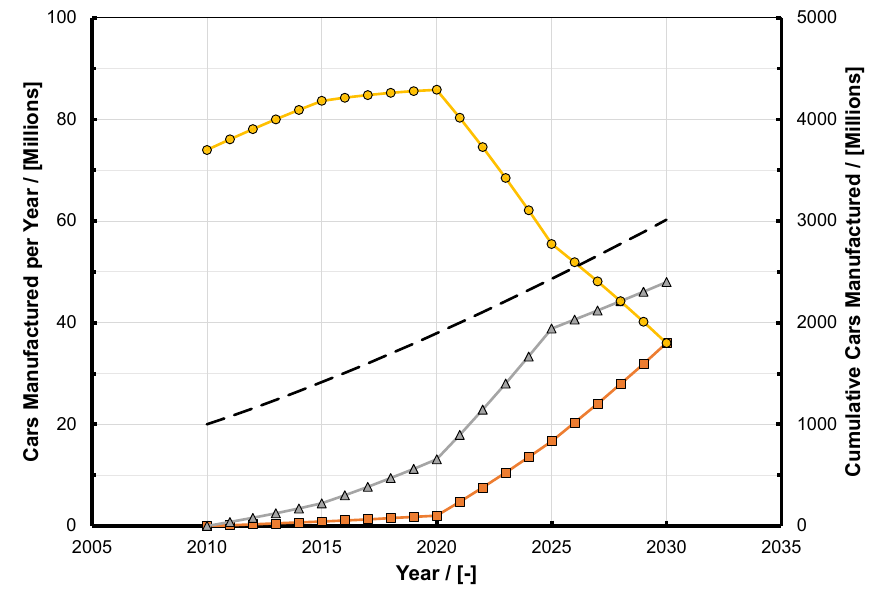
Figure 1. Projected production volumes of cars split into di ff erent propulsion types (data adapted from that given in [2]). BEV: battery electric vehicle; HEV: hybrid electric vehicle; PHEV: plug-in hybrid electric vehicle. ICE: internal combustion engine.